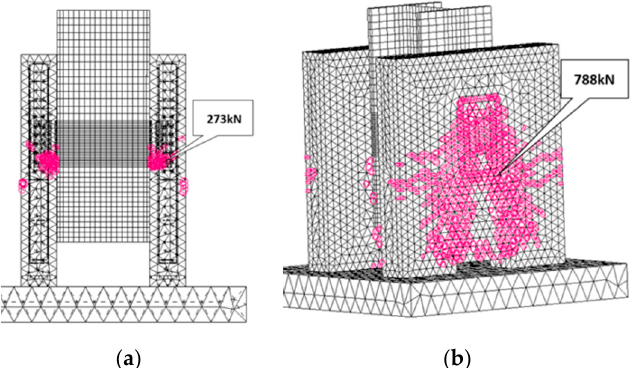
Figure 12. Theoretically different cracking of RPC specimens in intermediate stage ( a ) and at remarkably higher ultimate load ( b ).